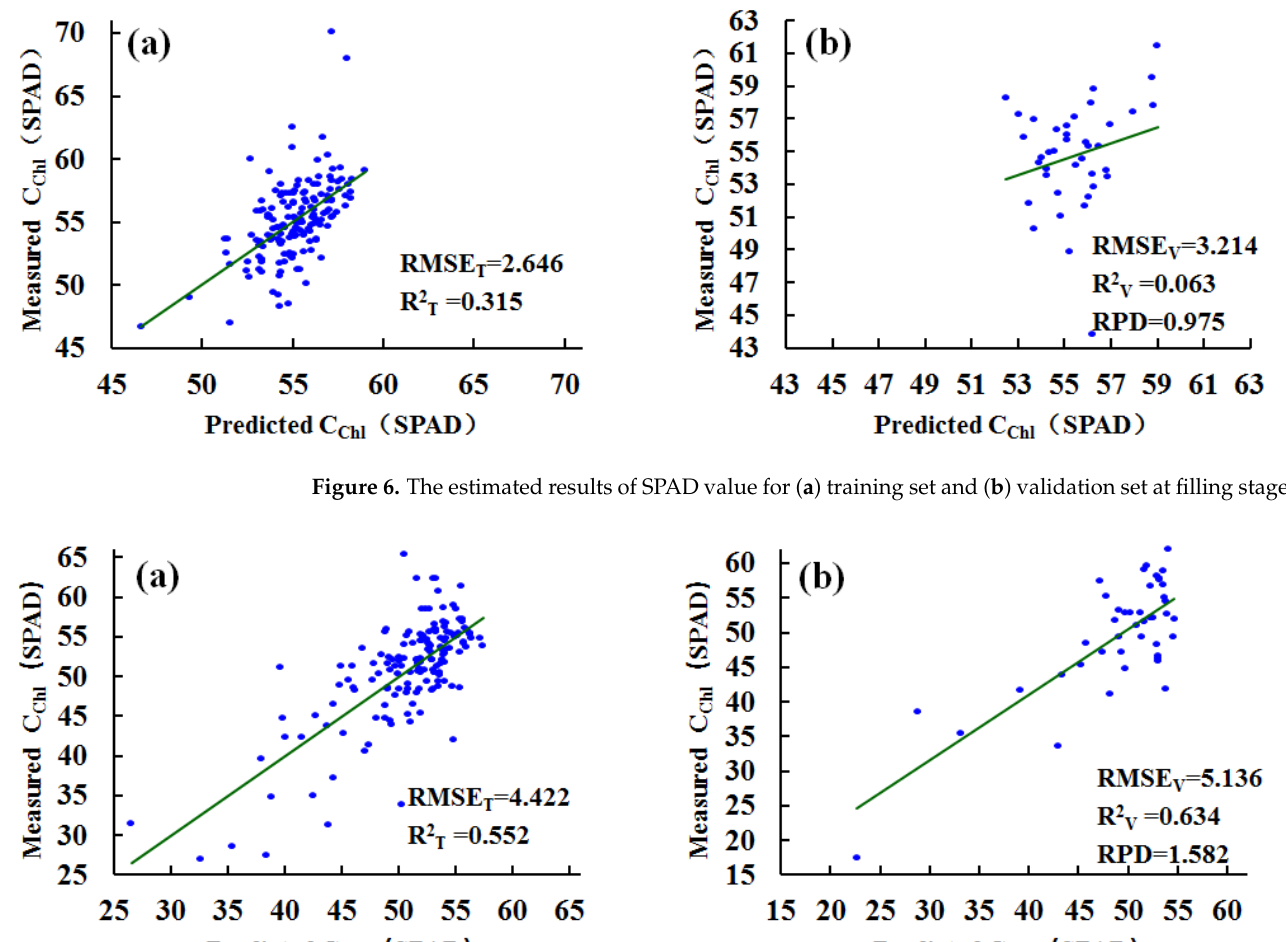
Figure 5. The estimated results of SPAD value for ( a ) training set and ( b ) validation set at flower- ing stage.